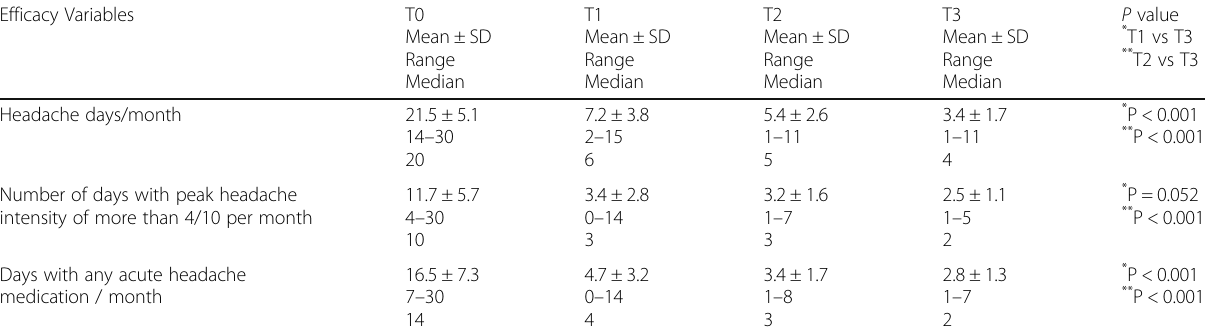
Table 3 Longitudinal changes in all efficacy variables from baseline (T0 - trimester before initiation of therapy) over three years of onabotulinumtoxinA (Botox ®) (T3) in 56 patients Efficacy